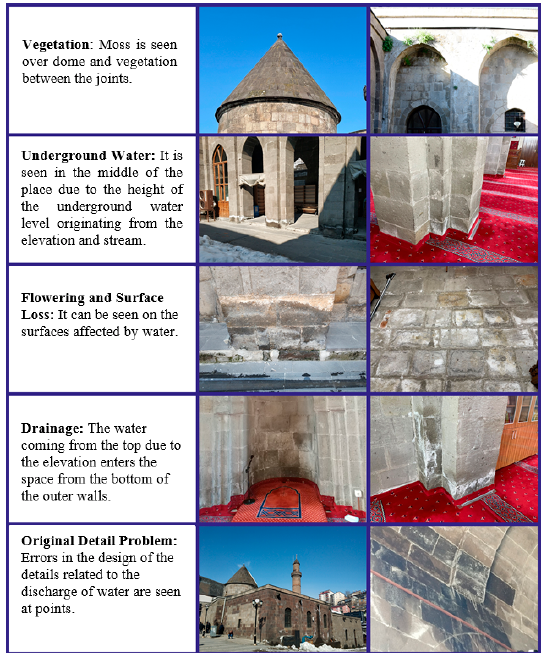
Figure 10. Damages observed in the Ulu Mosque.